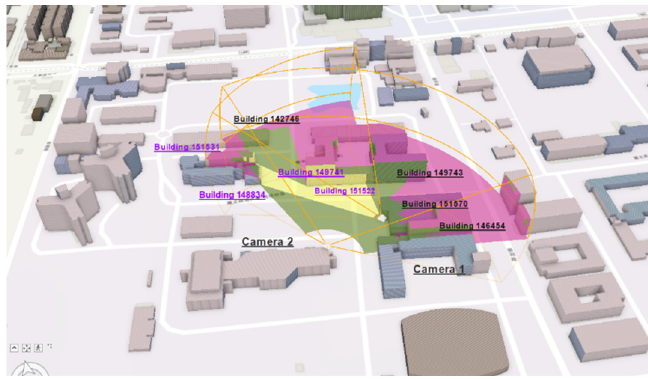
Figure 16. Multiple CCTV systems coverage.